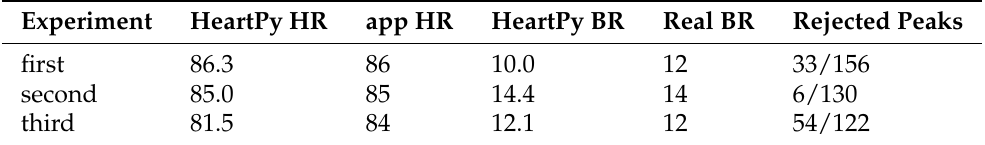
Table 1. HR (HeartPy and application), BR (HeartPy and counted) and number of rejected peaks (HeartPy) in all three experiments.